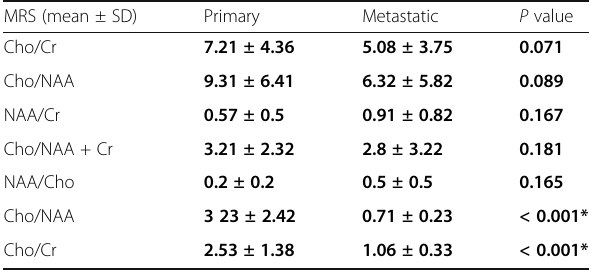
Table 4 Spectroscopic data intra-lesional within and outside tumor margin of the primary and metastatic neoplastic